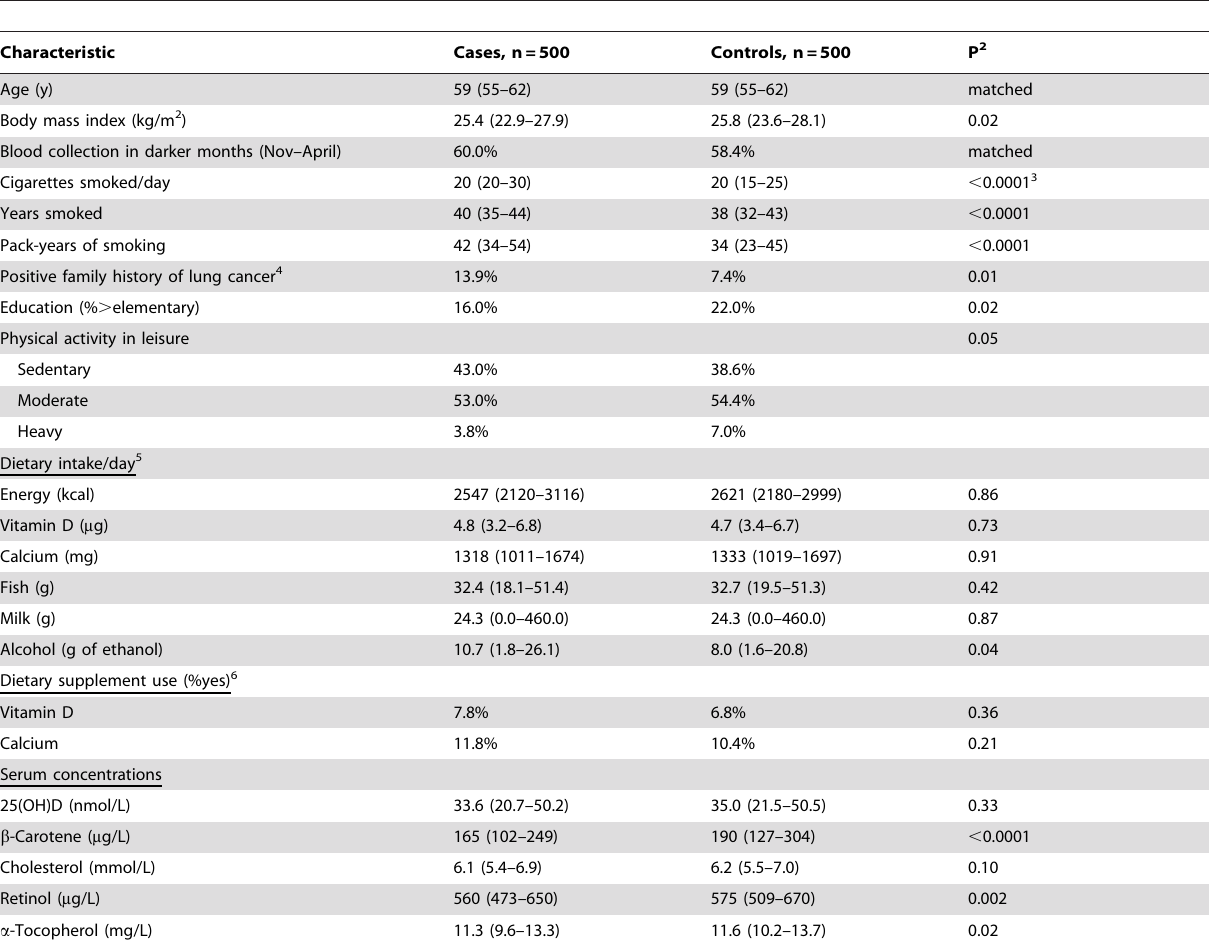
Table 1. Selected baseline characteristics of cases and controls, 1 Alpha-Tocopherol, Beta-Carotene Cancer Prevention